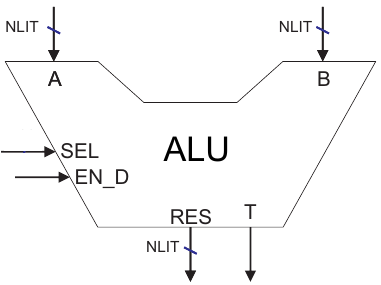
Figure 10. Logic block of the integer arithmetic unit.